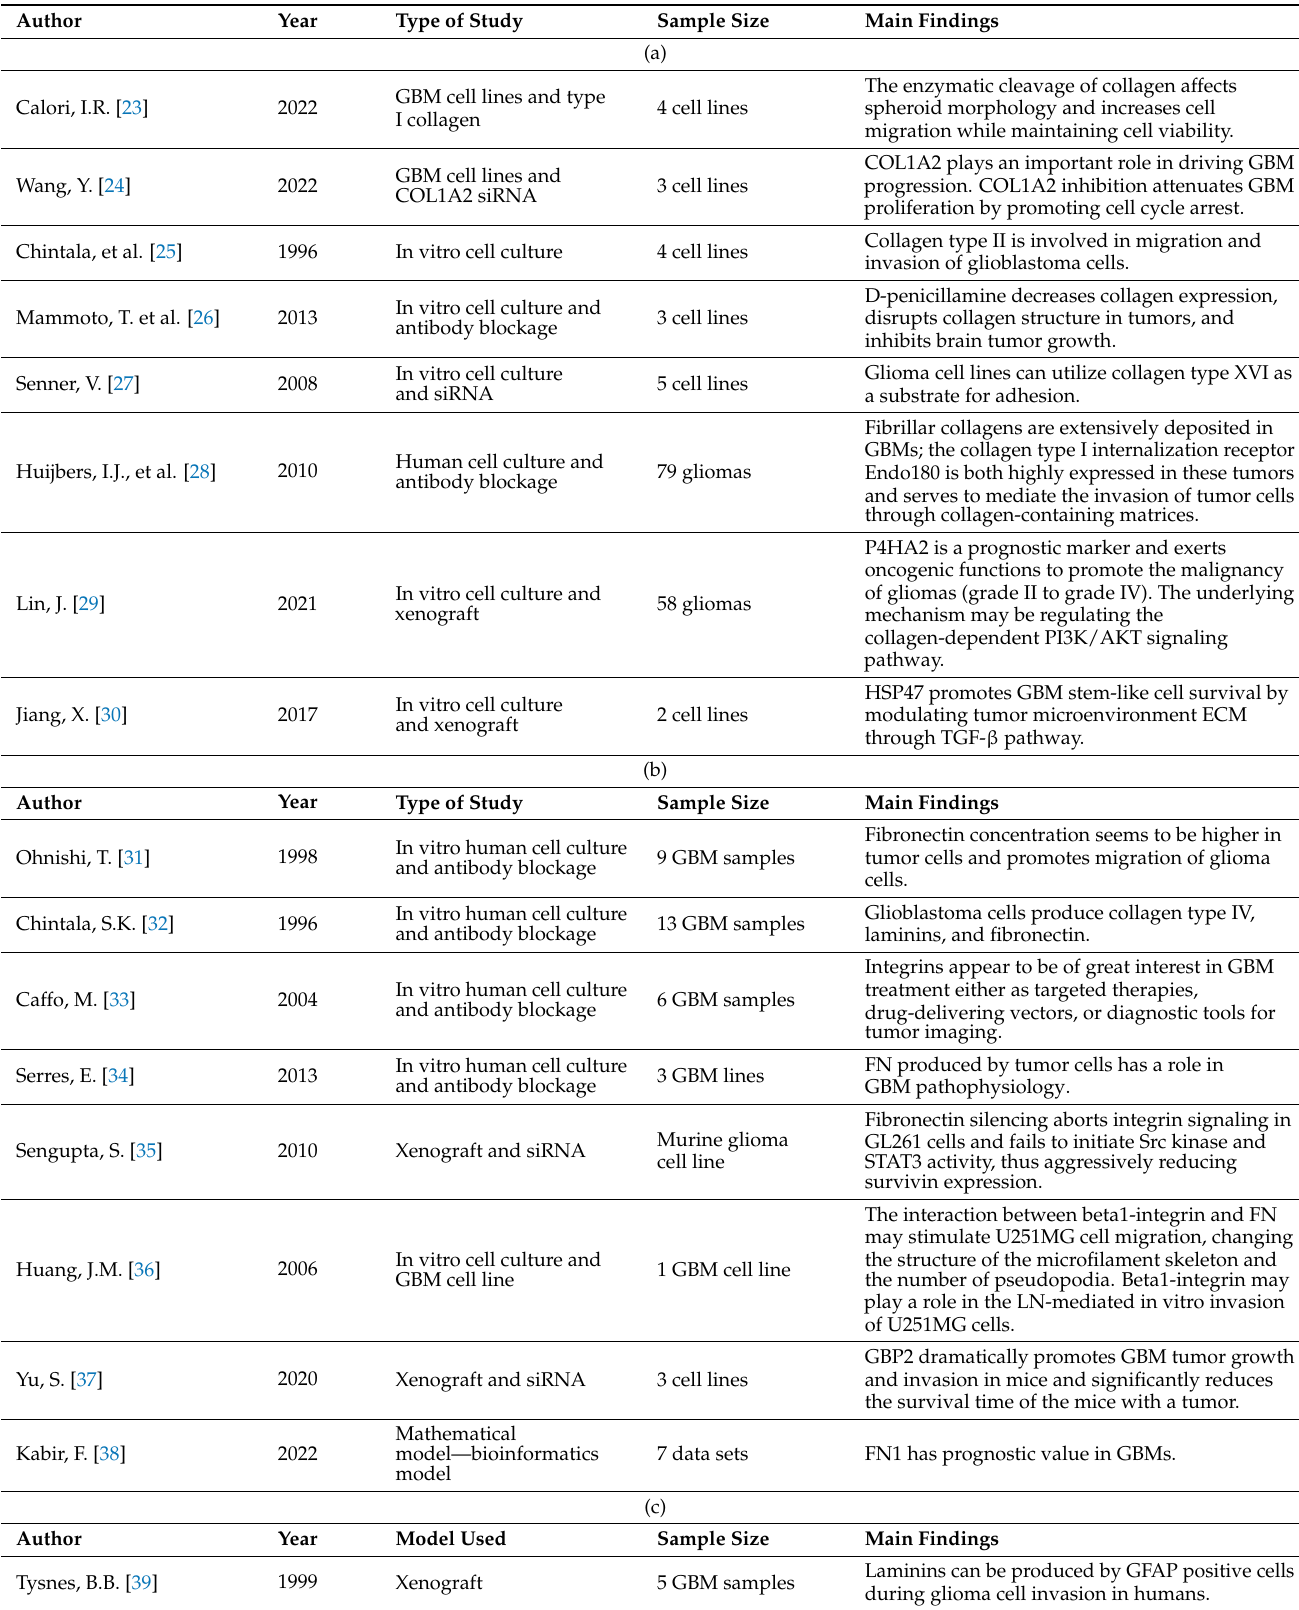
Table 2. (a) Collagen, (b) fibronectin, and (c)